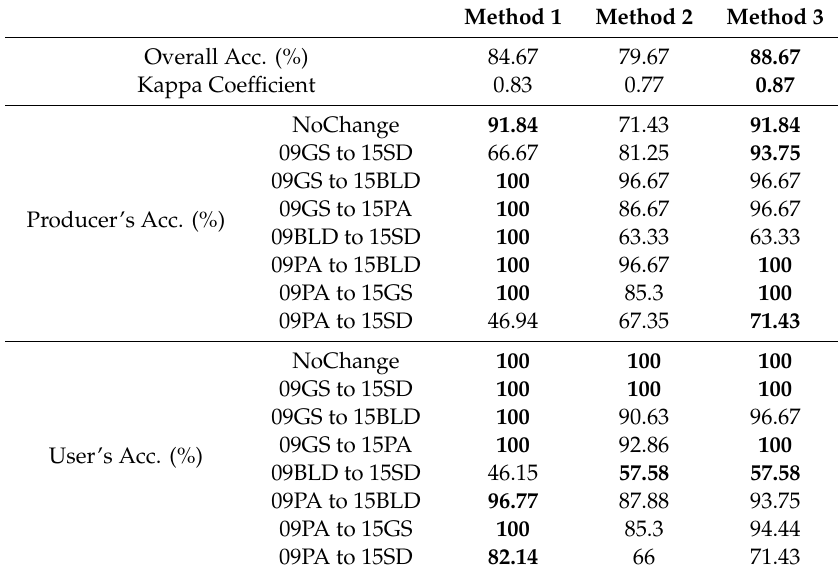
Table 9. The classification accuracies of changes in Method 1–3. Bold values refer to the highest